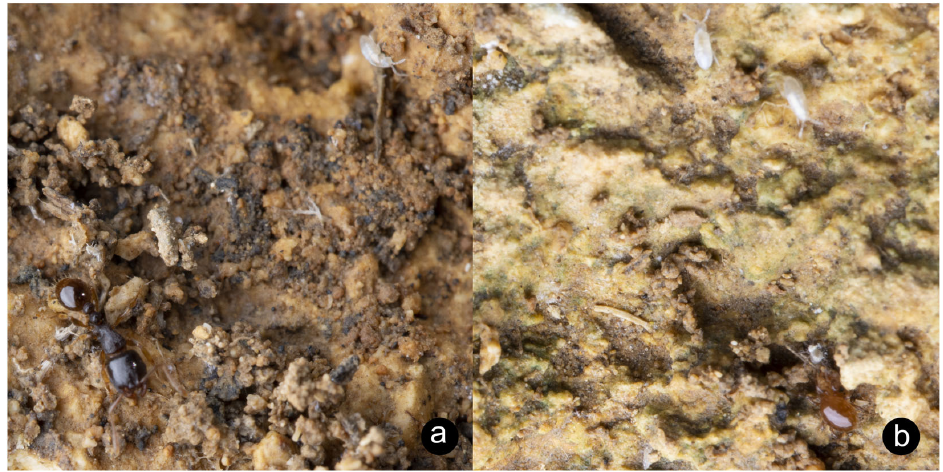
Figure 4. Cyphoderus albinus in an ants’ nest in Rabat; ( a ) one individual (top right) with Tetramorium worker (bottom left), Chadwick Lakes; ( b ) same nest as 4 ( a ), two Cyphoderus albinus (top) and a laelapid mite (bottom right).